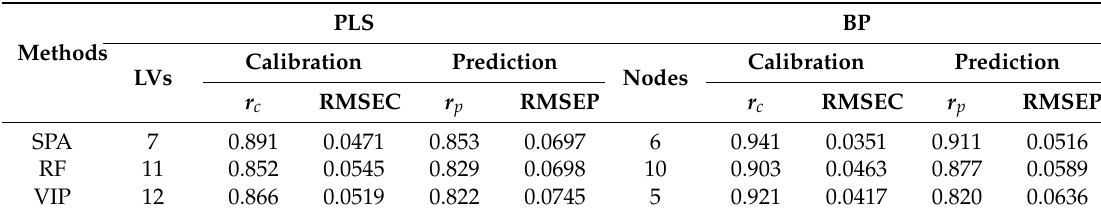
Table 4. The results of PLS models and BPNN models on optimal wavelengths selected by SPA, RF and VIP.